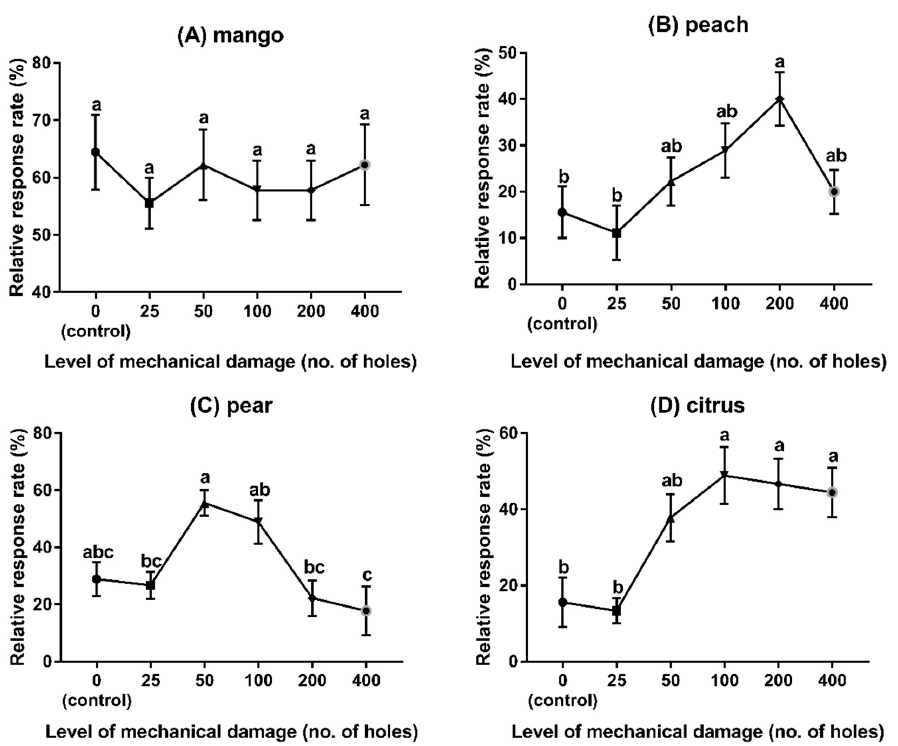
Figure 3. Behavioural responses of F. arisanus females to different fruits species with different levels of mechanical damage. ( A ) mango, ( B ) peach, ( C ) pear, ( D ) citrus. The data are expressed as mean ± SD. Different lowercase letters denote significant differences by Tukey’s multiple range test ( p < 0.05). N = 9.